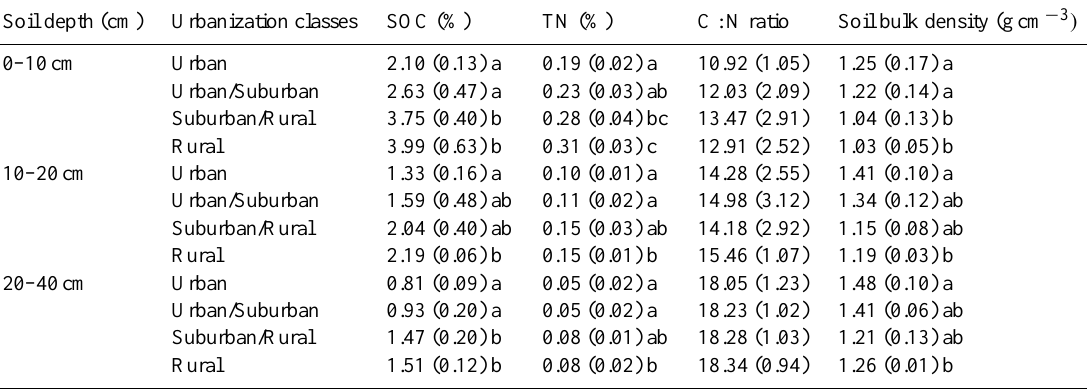
The different letters indicate significant differences at P <0.05 level, and no letters indicate no significant differences between different urbanization gradient classes, respectively (SNK test). Values are means with S. E. in parentheses ( N = 3 for urban and rural, N = 4 for urban/suburban and suburban/rural).